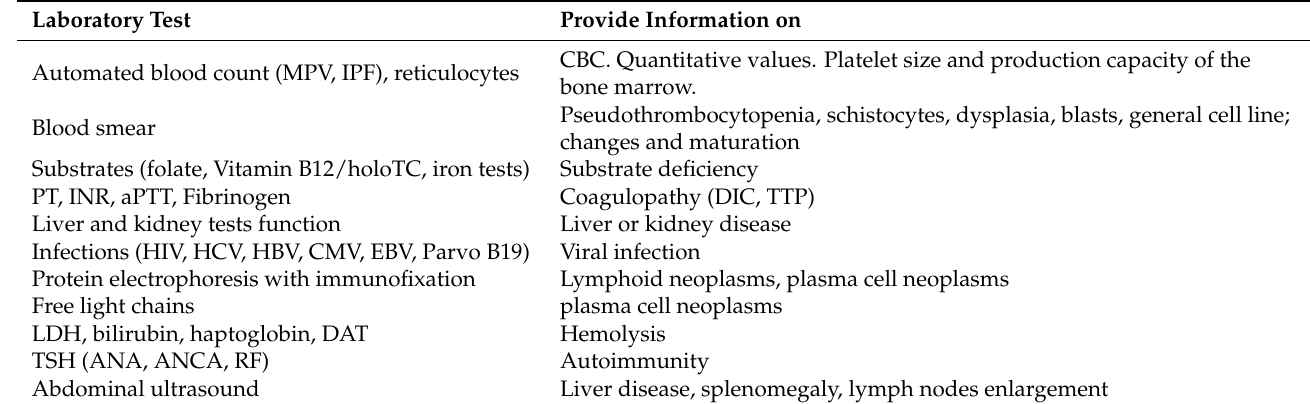
Table 1. Primary laboratory evaluation in patients with unexplained